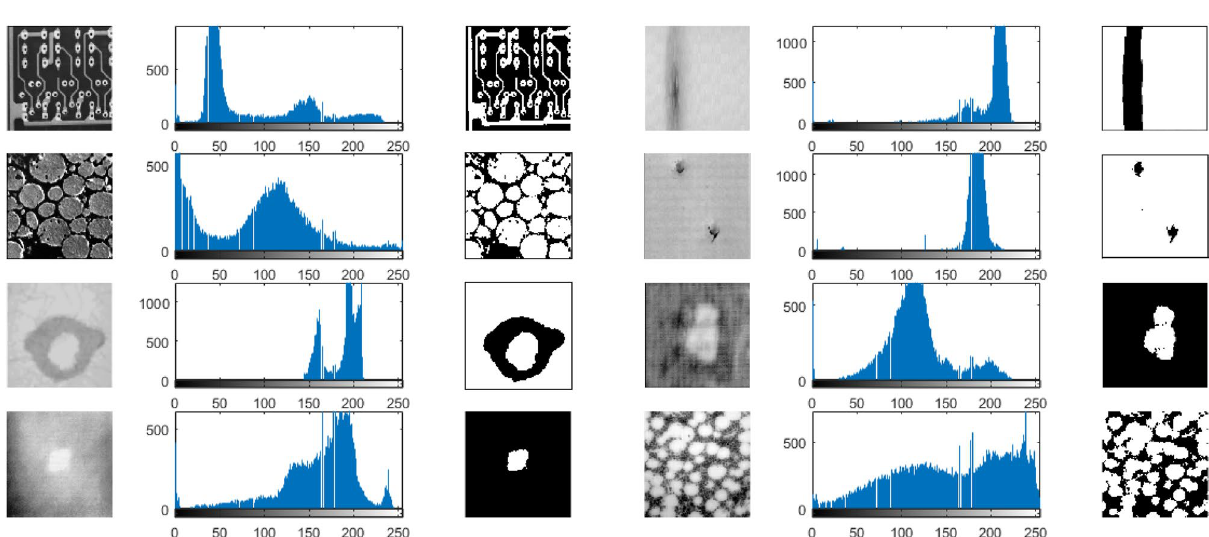
Figure 4. The experimental NDT images, their histograms and ground-truth